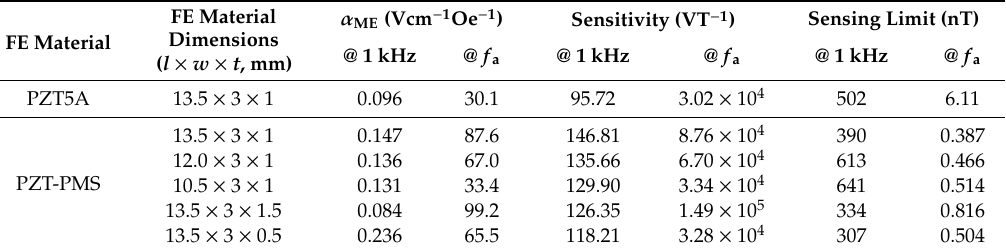
Table 2. Magnetoelectric voltage coe ffi cient ( α ME ), magnetic field sensitivity, and sensing limit of PZT5A and PZT-PMS